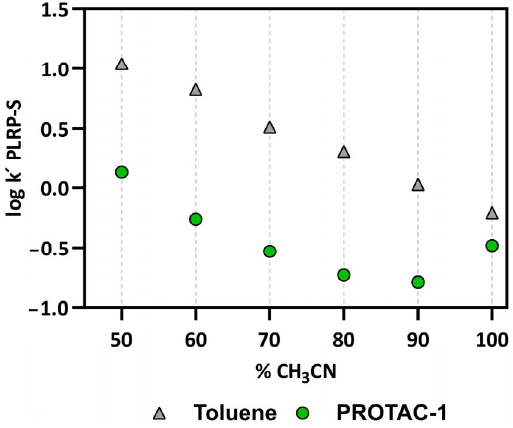
Figure 3. log k (cid:48) measured using a PLRP-S stationary phase and increasing percentages of acetonitrile Figure 3. log k ′ measured using a PLRP ‐ S stationary phase and increasing percentages of acetonitrile in the mobile phase for PROTAC-1 (green) and toluene (negative control, in the mobile phase for PROTAC ‐ 1 (green) and toluene (negative control, grey).